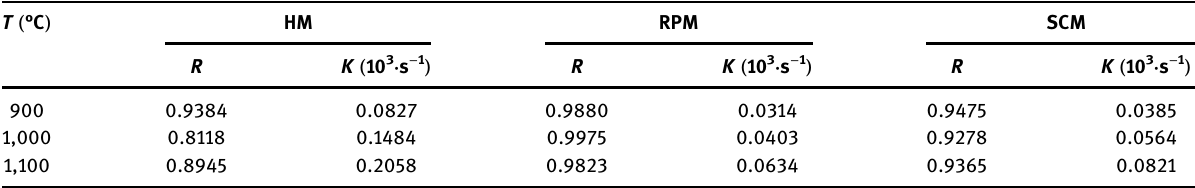
Table 4: Fitting parameters of di ff erent kinetic models